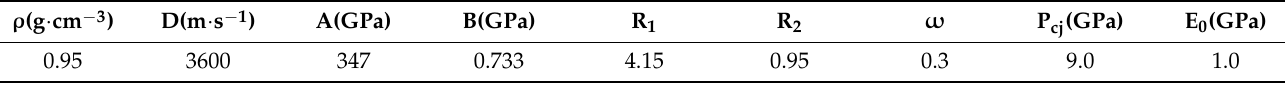
Table 2. The parameters of the JWL equation of state for explosives.